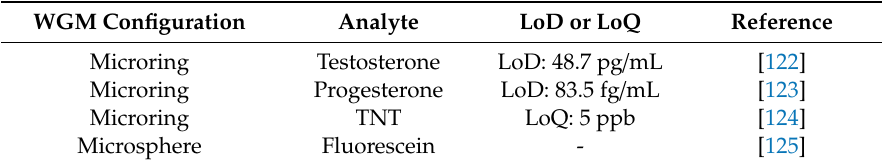
Table 4. MIPs coupled to whispering gallery modes